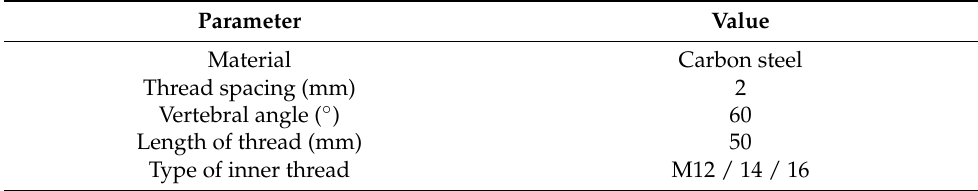
Table 3 . Parameters of the steel connector . Table 3. Parameters of the steel connector.